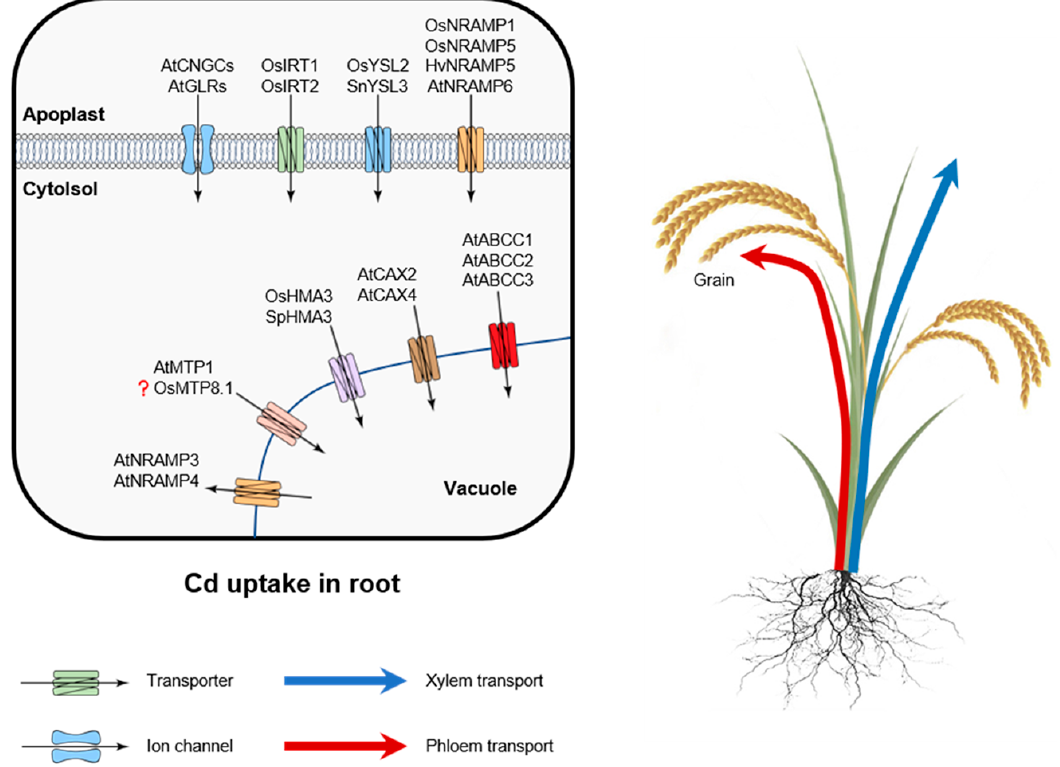
Figure 2. Uptake and intracellular compartmentation of cadmium in plant roots. Cd taken up by IRT1 / 2 (zinc / iron-regulated transporter-like protein), YSL2 / 3 (yellow stripe-like protein), and NRAMP1 / 5 / 6 (natural resistance-associated macrophage protein) transporters that are located at the plasma membrane of the root epidermis. Cd can be also transported into cells through non-selective cation (NSCC) channels such as CNGCs (cyclic nucleotide-gated channels) and GLRs (glutamate receptors). ABCC (ATP-binding cassette transporters), CAX (cation exchanger), HMA3 (metal-transporting ATPases), MTP1 (metal tolerance protein), and NRAMP3 / 4 mediate Cd transport and sequestration in the vacuole.